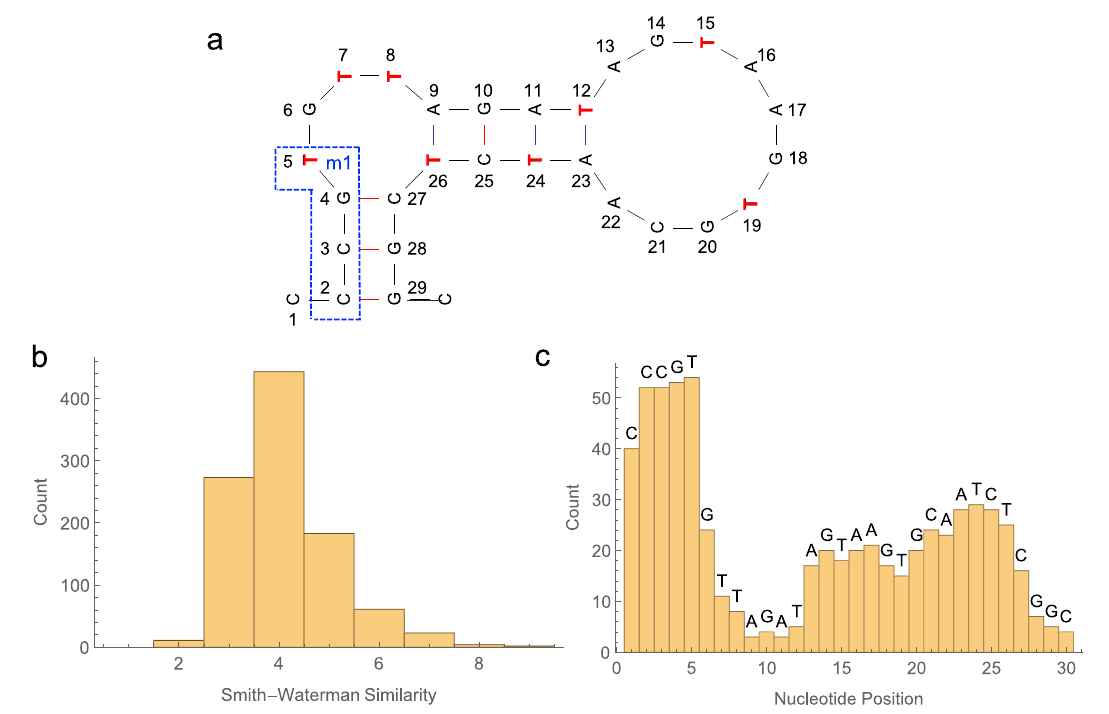
Fig. 4 | Analysis of the top 1000 unique glucose SD sequences. a Predicted secondarystructureofthephenylboronicacid-modi fi edglucoseaptamerNNGmin. Red bolded Ts denote location of modi fi cations. The boxed region m1 indicates a motif thatwashighly recurrent among the sequence elements targeted by our top SDs. b Histogram of the frequency with which each aptamer base-position was